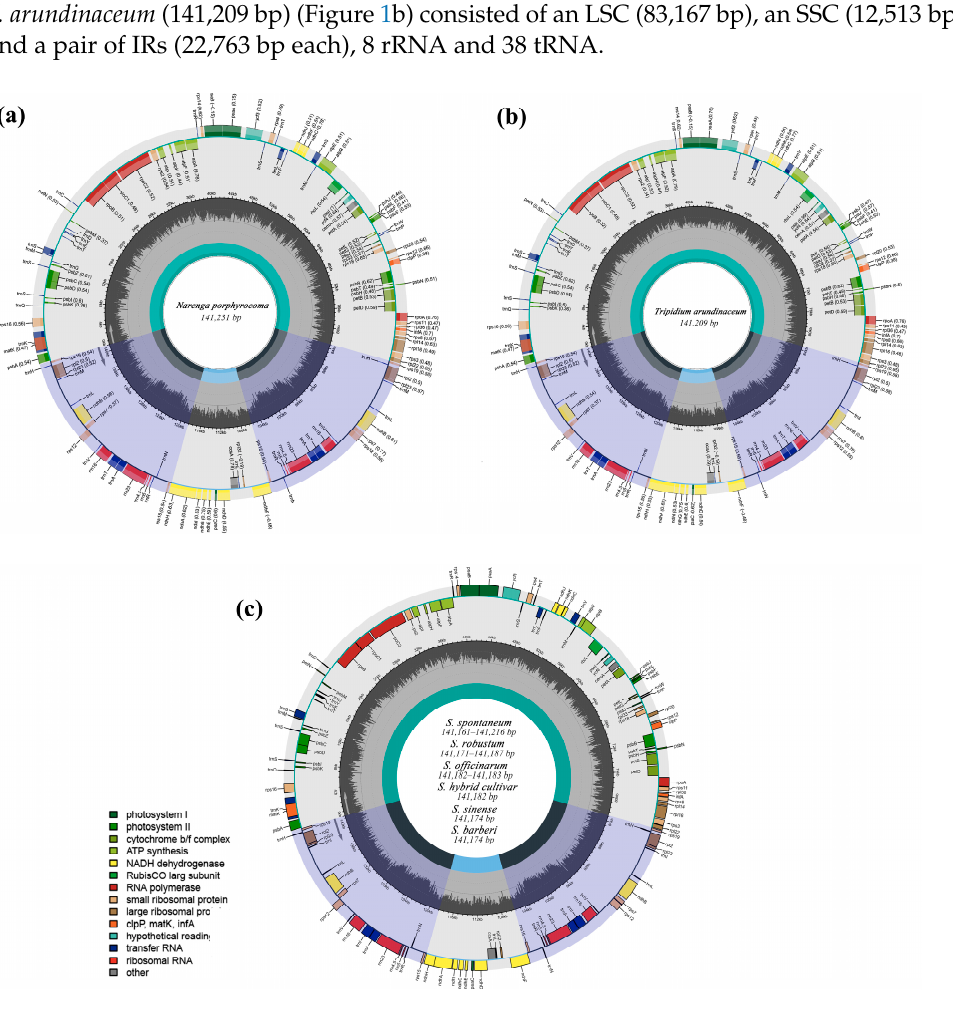
Figure 1. Structure of the assembled and annotated chloroplast genomes. The color of genes indicate their function. The genes presented outside the circle are transcribed counterclockwise, whereas the genes presented inside the circle are transcribed clockwise. The gene content and organization are similar for all Saccharum species, and, therefore, one figure ( c ) is drawn as representative of all three species. ( a ) N. porphyrocoma ; ( b ) T. arundinaceum ; ( c ) Saccharum species. In Saccharum , assembly sizes ranged from 141,161 bp (IND81-013, S. spontaneum ) to 141,216 bp (SP79-9, S. spontaneum ) (Figure 1c). All had a typical quadripartite structure, comprising an SSC (12,538–12,542 bp) and an LSC (82,036–83,093 bp) region separated by a pair of IRs (22,789–22,795 bp). The cp genome length varied from 141,161 to 141,216 bp,